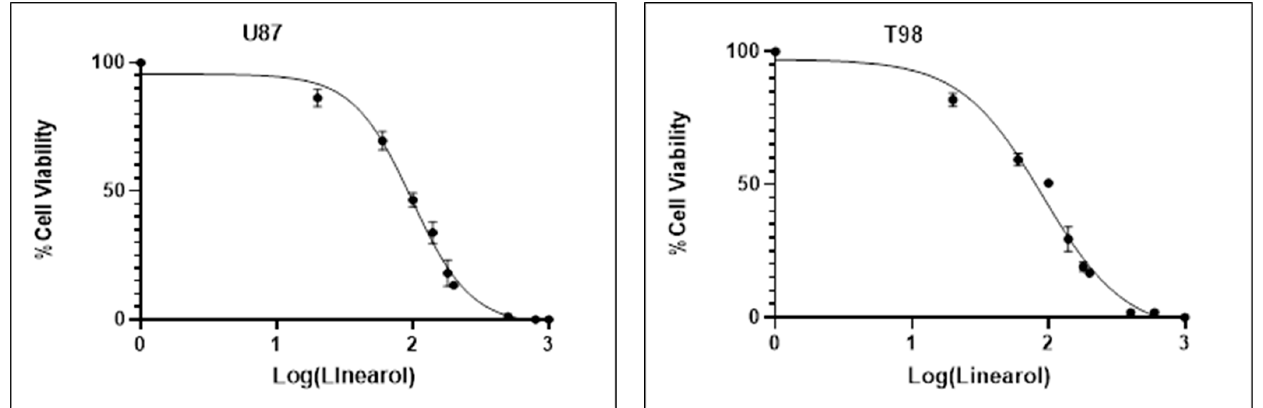
Figure 2. Linearol inhibits T98 and U87 cell proliferation. Cells were quantified by staining with Trypan Blue at 72 h post-treatment and data shown are the means (±S.D.) from 3 different experiments performed in triplicate. The IC50 values were determined using the non-linear regression analysis model of GraphPad Prism.